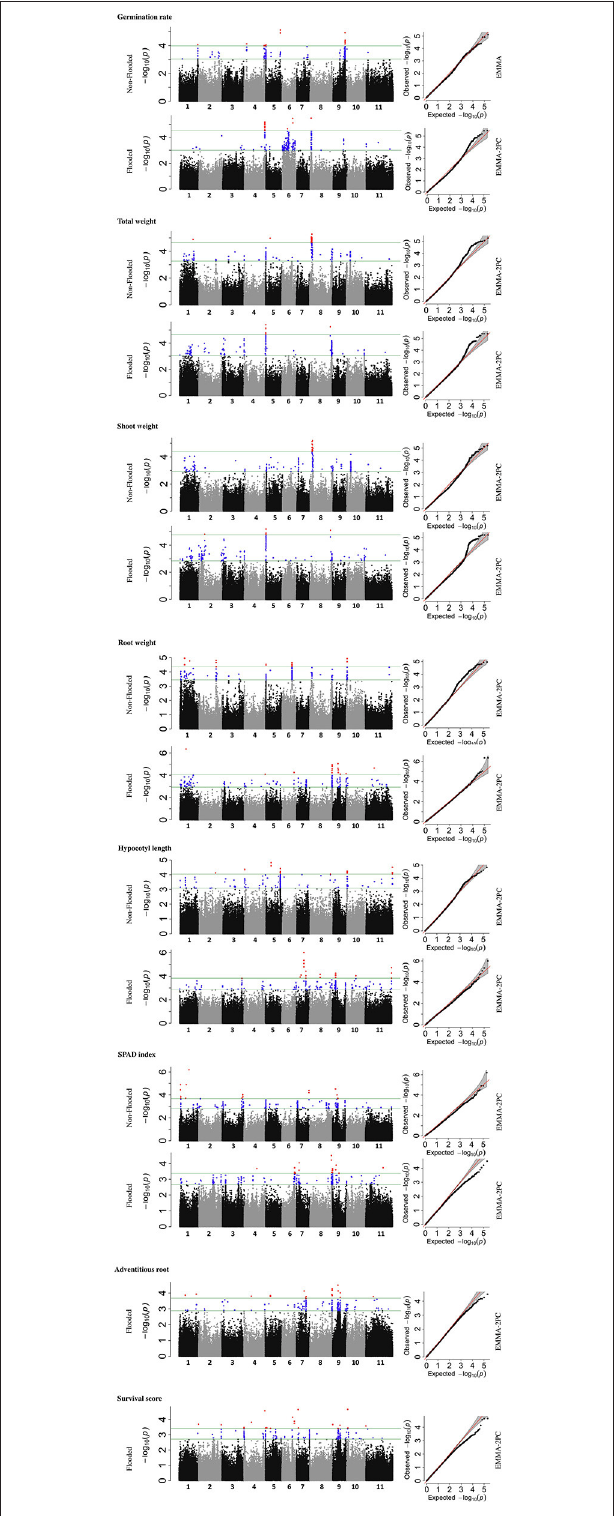
FIGURE 5 | Manhattan and corresponding Q-Q plots represents the genetic architecture of different traits under flooded and non-flooded condition.